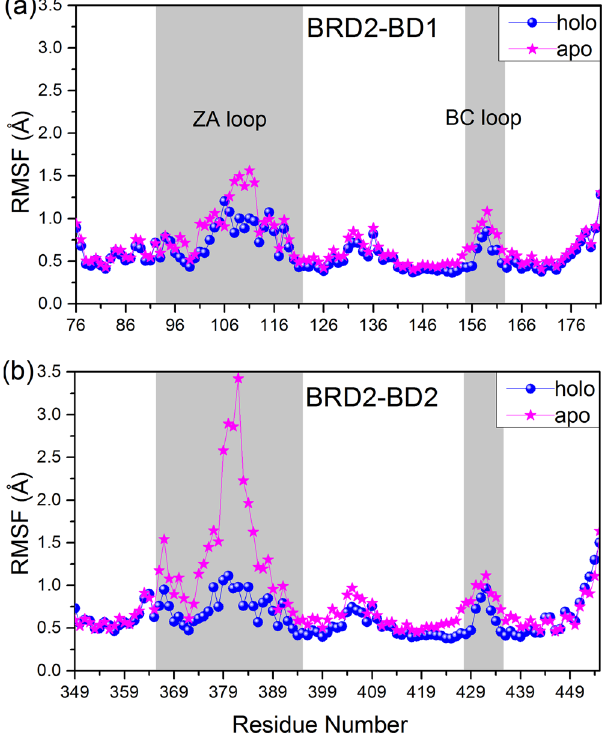
Figure 6. RMSFs as a function of residues in apo and holo systems of ( a ) BRD2-BD1 and ( b ) BRD2-BD2.